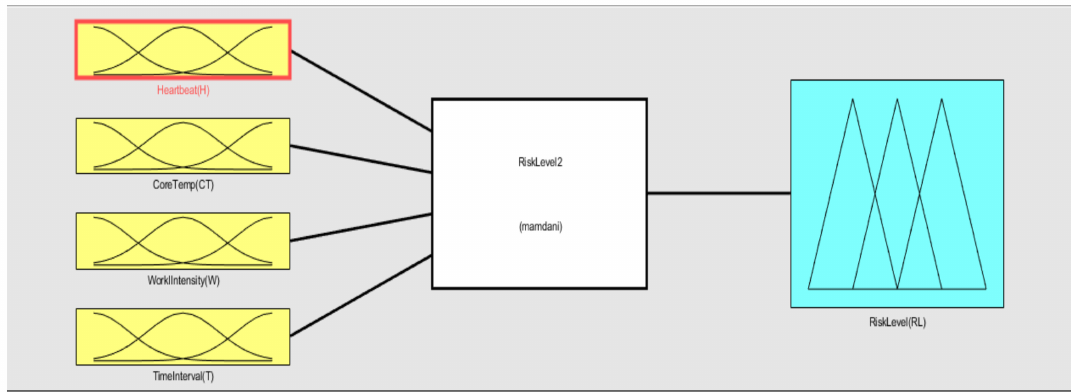
Figure 8. Membership function plot.